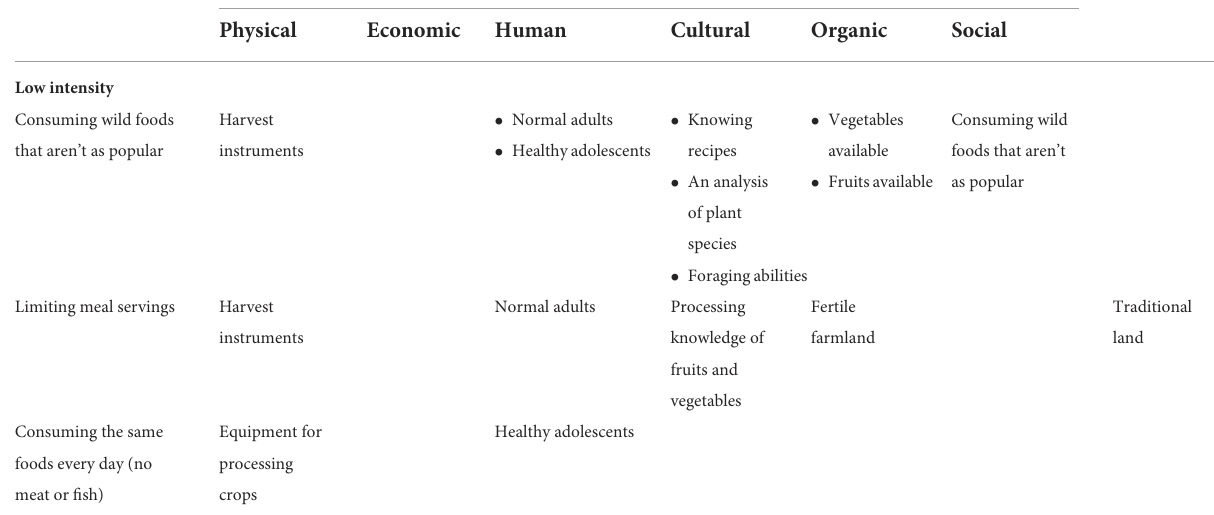
TABLE 4 Addressing food insecurity with low